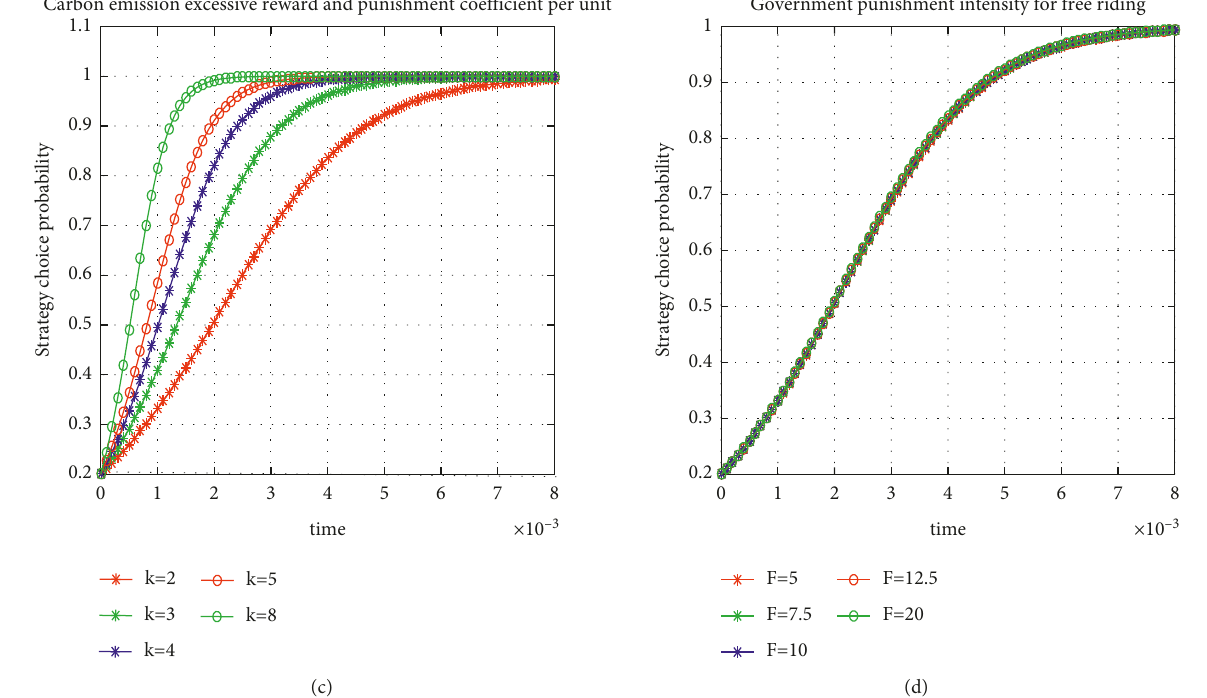
Figure 2: Impact of different parameter changes on carbon emission reduction investment behavior of supply chain